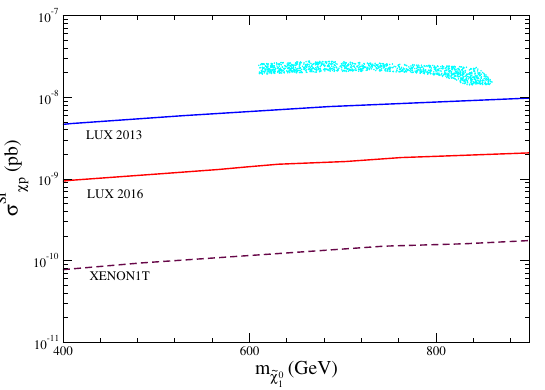
Figure 2 . Direct detection results for compressed model. LUX and XENON1T results are shown as solid red and dashed magenta lines respectively. Blue points satisfy WMAP/PLANCK data, LHC constraints and a (cid:22) up to the level of 2 (cid:27)